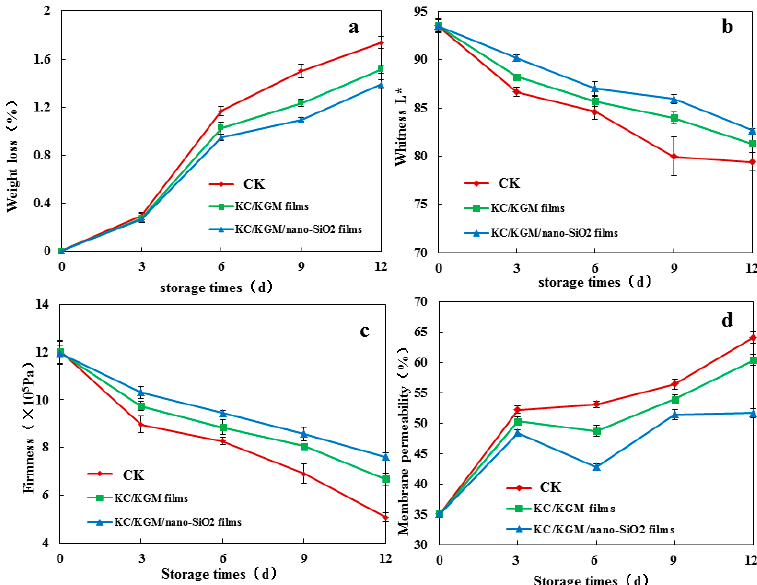
1 ◦ C for 12 d (1: CK; 2: ±